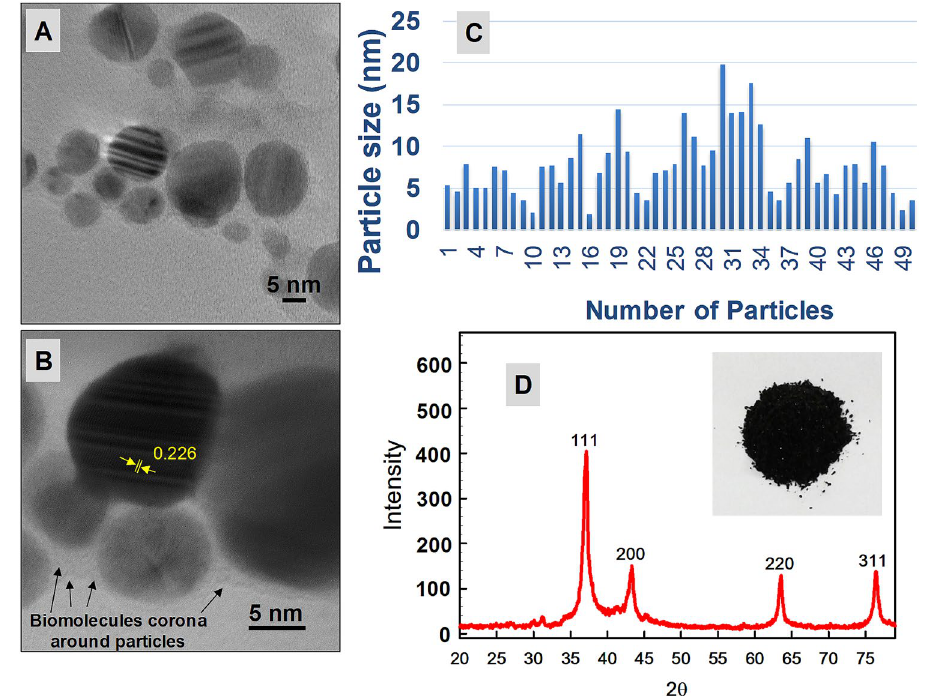
Figure 4. TEM micrographs of PB extract-capped Pd-NPs at direct magnification of 300000X (panel A) and × 800,000 (panel B). Panel C shows particle size distribution while panel D represent XRD spectra with inset image of Pd-NPs